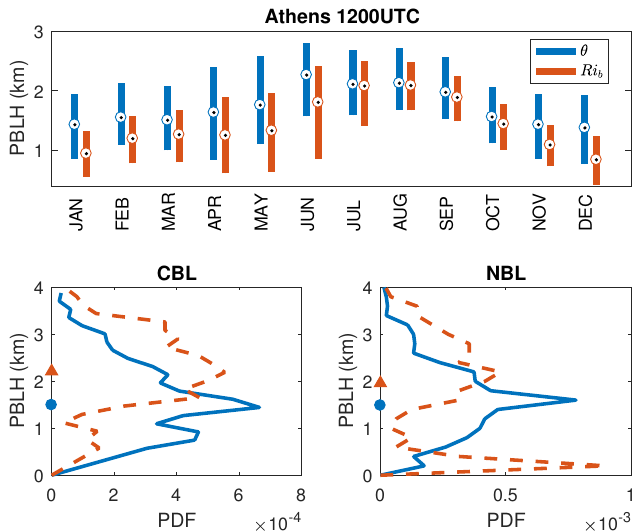
Figure 5. Upper panel: Distribution of the PBLH for each month of the year. The PBLH is estimated using the gradient (denoted as θ in the insert) and the bulk Richardson number (denoted as Ri b in the insert) methods for the 1200UTC soundings over Athens. The box plot shows the 25th and 75th percentile values and the open circle shows the median. Lower panels: Probability Density Function (PDF) of the PBLH for the CBL (lower left panel) and NBL (lower right panel) types estimated using the gradient method. Shown are the PDFs for DJF (solid line) and for JJA (dashed line). Also shown are the corresponding median values of the distributions for DJF (circles) and JJA